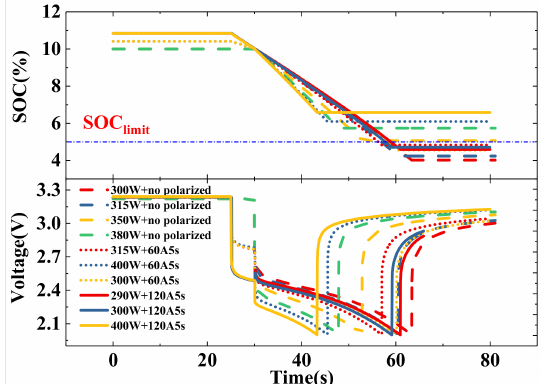
Figure 15. Voltage and SOC of batteries under constant power pulse test at 0 degrees Celsius considering different initial polarization.